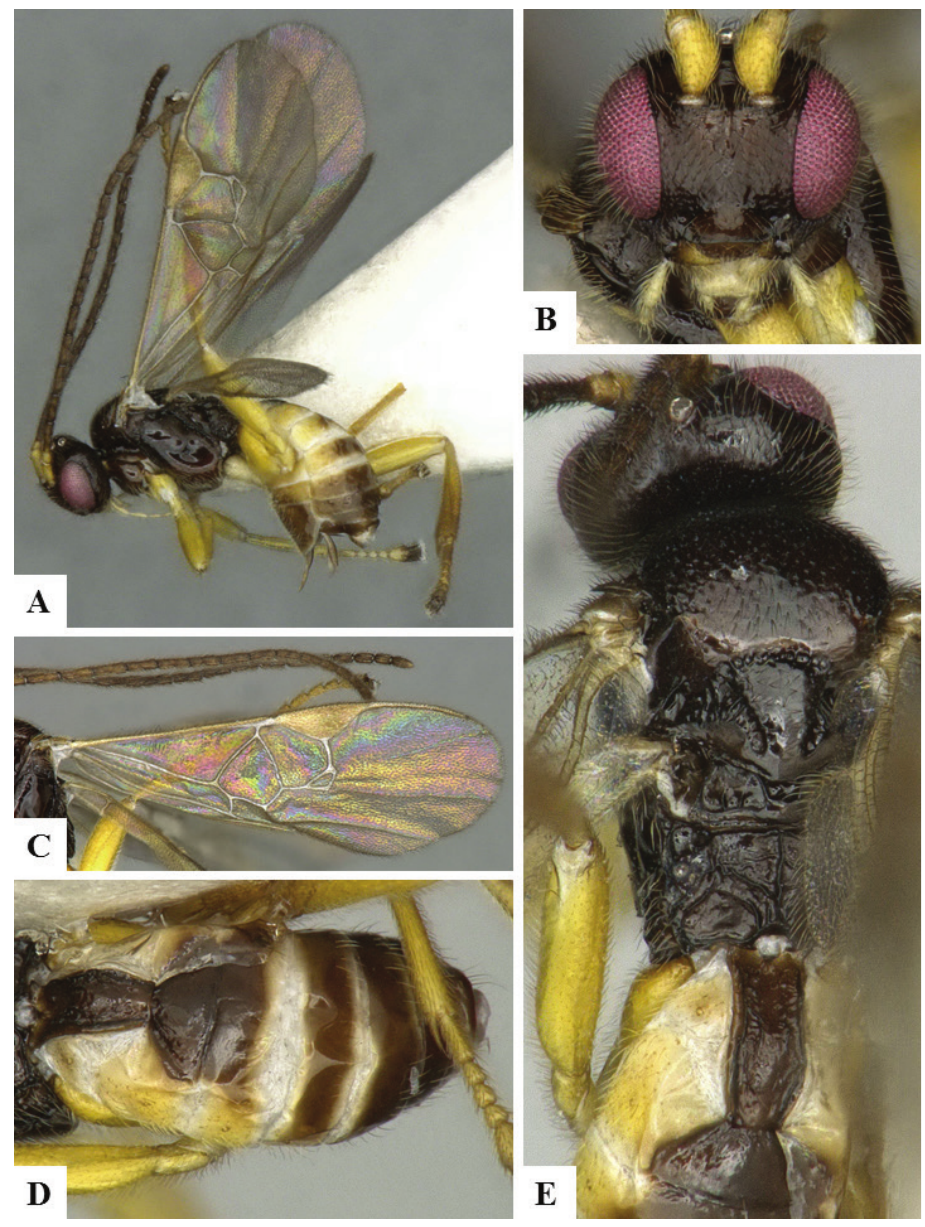
Figure 38. Ungunicus vietnamensis female holotype. A Habitus B Head frontal C Fore wing D Metasoma dorsal E Head and mesosoma,